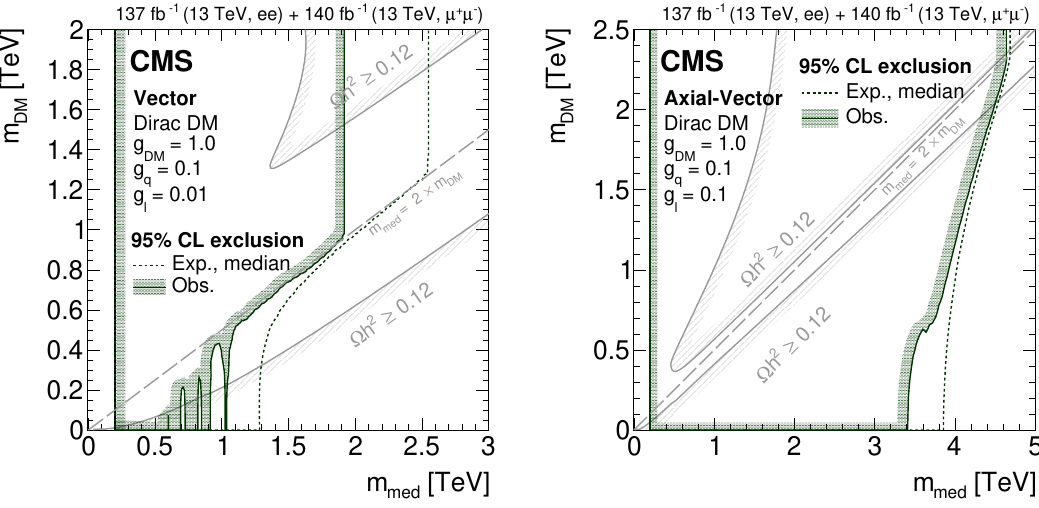
Figure 9 . Summary of upper limits at 95% CL on the masses of the DM particle, which is assumed to be a Dirac fermion, and its associated mediator, in a simplified model of DM production via a (left) vector or (right) axial-vector mediator. The parameter exclusion regions are obtained by comparing the limits on the product of the production cross section and the branching fraction for decay to a Z boson with the values obtained from calculations in the simplified model. For each combination of the DM particle and mediator mass values, the width of the mediator is taken into account in the limit calculation. The curves with the hatching represent the excluded regions. The solid gray curves, marked as “ Ω h 2 ≥ 0 . 12 ”, correspond to parameter regions that reproduce the observed DM relic density in the universe [6, 48, 96, 97], with the hatched area indicating the region where the DM relic abundance exceeds the observed